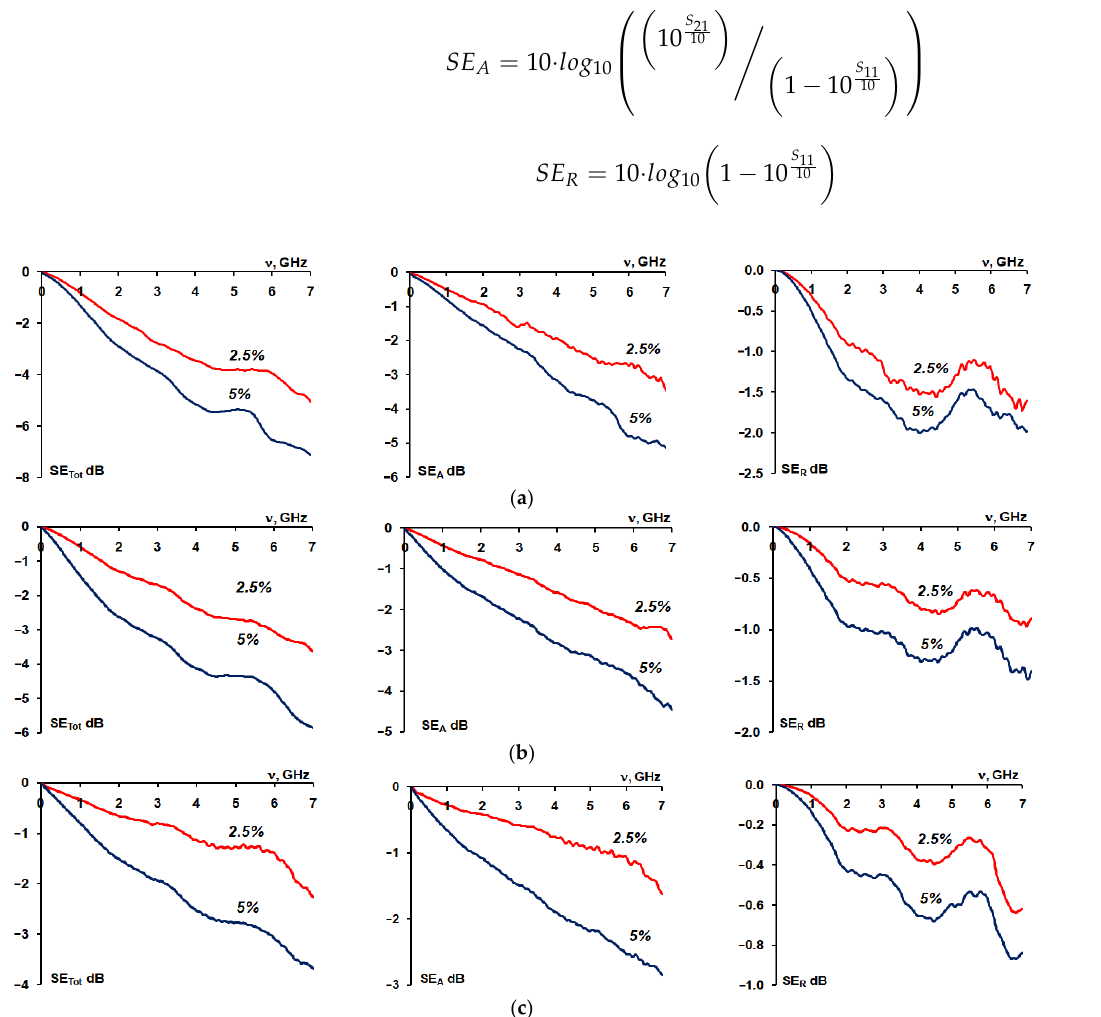
Figure 5. Total shielding effectiveness, shielding effectiveness due to absorption and shielding effectiveness due to reflection of metallized glass fiber composites: ( a ) with brass film; ( b ) with neusilber film; ( с ) with SS304 film.